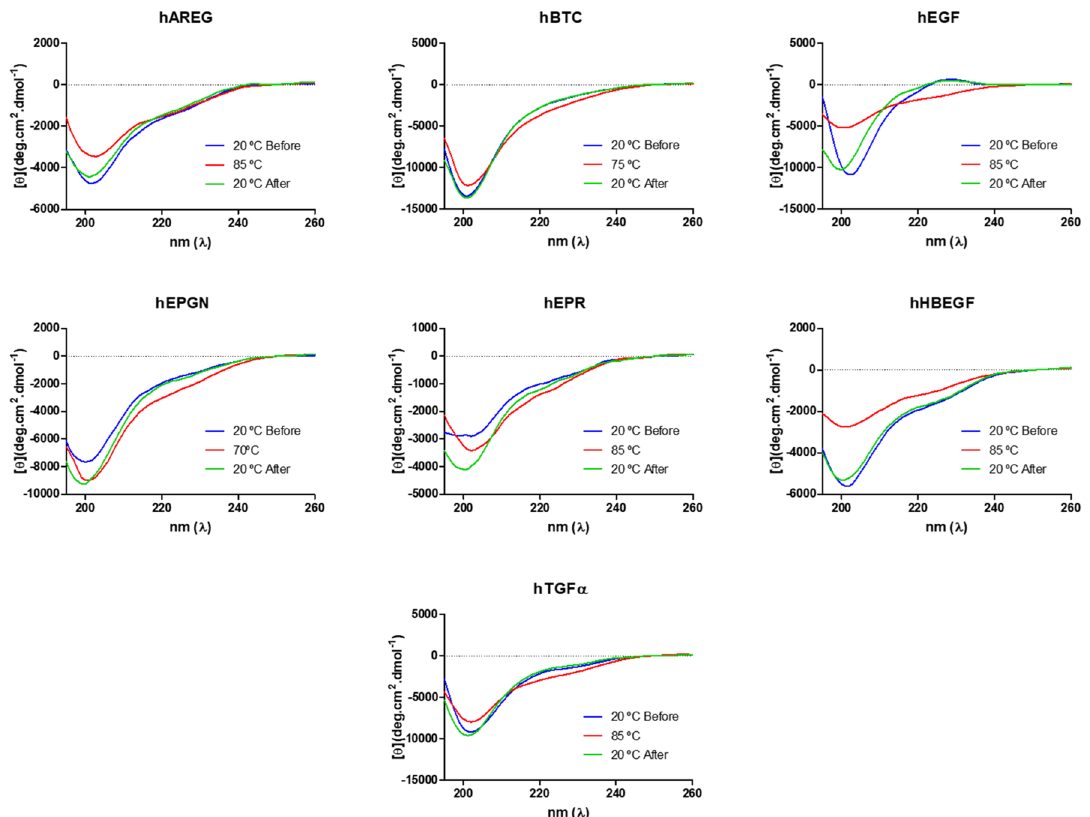
Figure 5. Circular dichroism spectra of the seven EGF growth factors. The blue lines correspond to the spectra acquired at 20 °C, the red lines to the spectra acquired after heating to the indicated temperatures and the green lines correspond to the spectra acquired after the temperature was reduced to 20 °C. The far-UV circular dichroism spectra (195–260 nm) were recorded using a J-815 spectropolarimeter with five accumulations and using a 1 mm path length